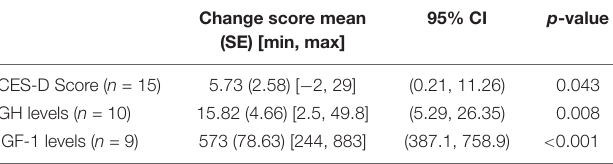
TABLE 2 | Analysis of change scores (pre-post) in acromegaly